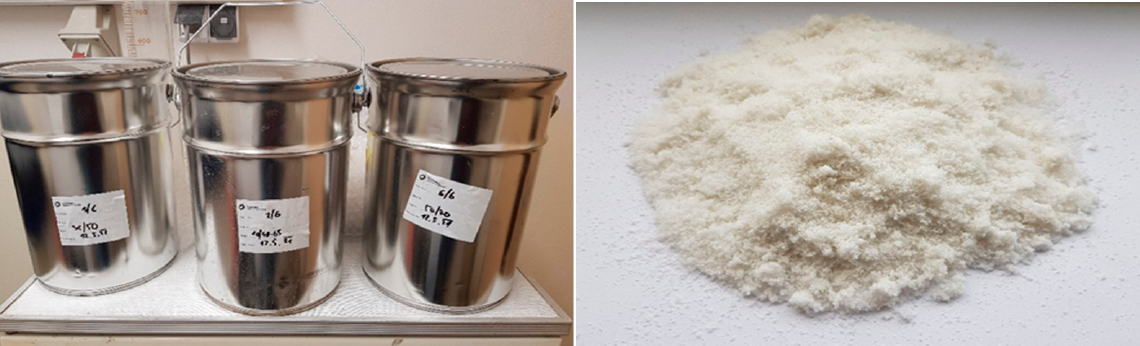
Figure 1. Materials for the first experiment of the interaction of straight run bitumen CA 35/50; 50/70 ( left ) and fast-reacting SBS polymer ( right ).